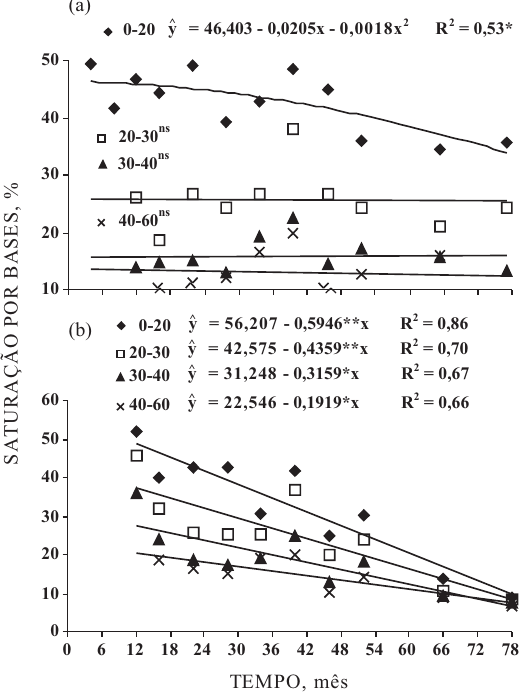
Figura 3. Efeito do tempo de aplicação do calcário na saturação por bases do solo cultivado com goiabeira, em amostras da entrelinha (a) e da linha (b) em diferentes profundidades de amostragem. Os pontos são médias de cinco doses de calcário e quatro repetições. ** Significativo p < 0,01 e * Significativo p <